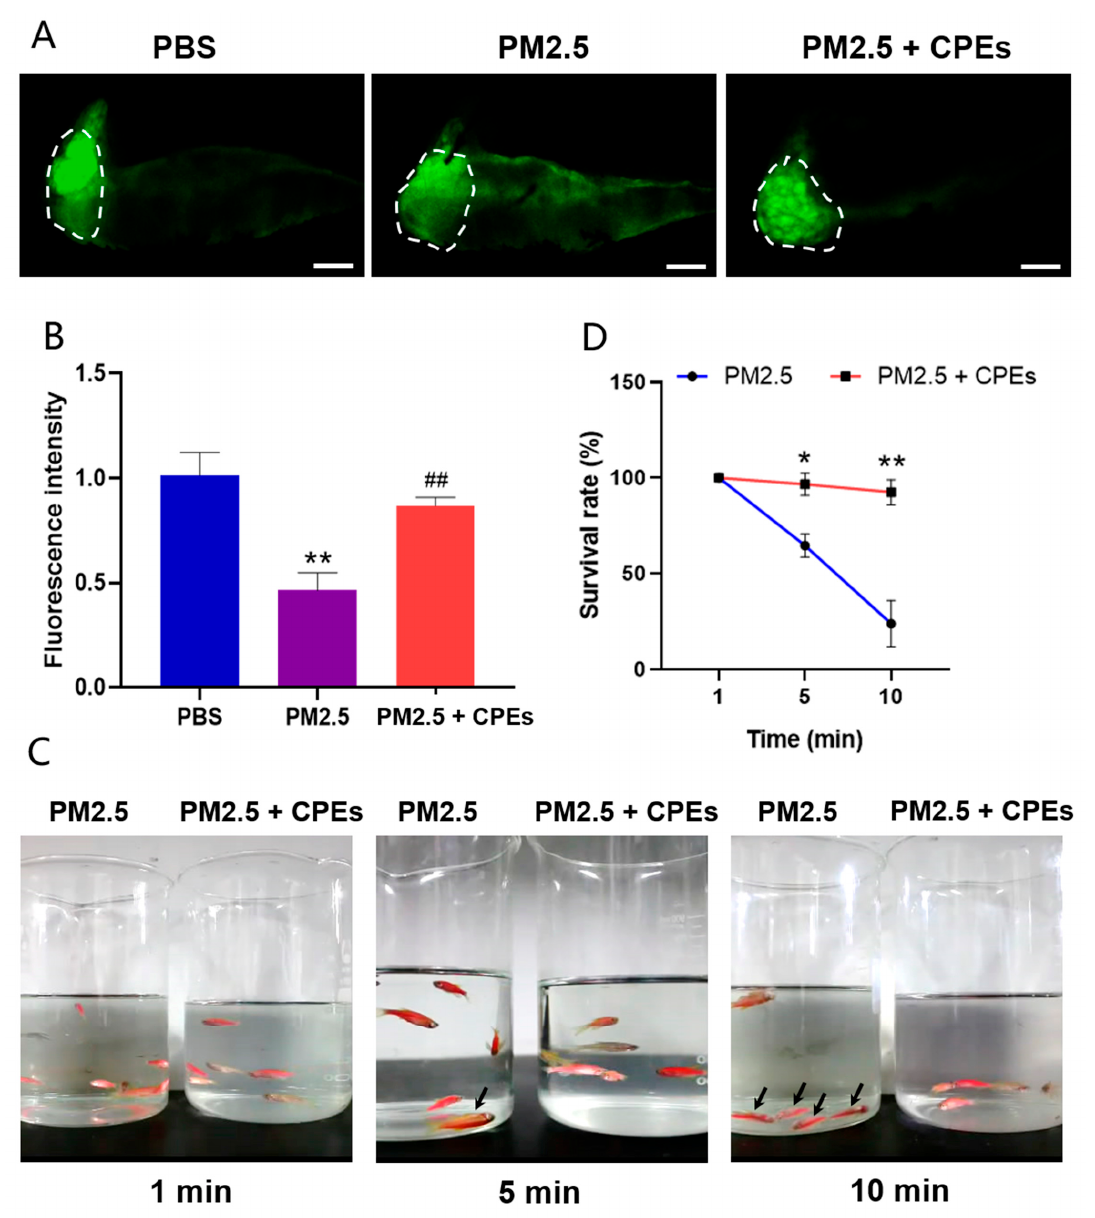
Figure 7. CPE protection effect in Zebrafish hepatotoxicity and survival assay against PM2.5. ( A ) Viviperception of the larvae tg (Apo14: GFP) liver phenotype by fluorescence microscopic images (green fluorescence and white outline, scale bar: 200 µm). ( B ) Fluorescence intensity of the liver of larval exposed to PM2.5 (100 µg mL − 1 ) under fluorescence microscopy. ( C ) Video capture of zebrafish survival state after treatment of PM2.5 (10 mg mL − 1 ) or plus CPEs (10 mg mL − 1 ) at 1, 5, 10 min (black arrow refers to dead zebrafishes). ( D ) The percentage of zebrafish survival rate. All results are expressed as mean ± SD of three biological replicates. ( B ) ** p < 0.01 compared with PBS, ## p < 0.01 compared with PM2.5. ( D ) * p < 0.05, ** p < 0.01 compared with PM2.5.